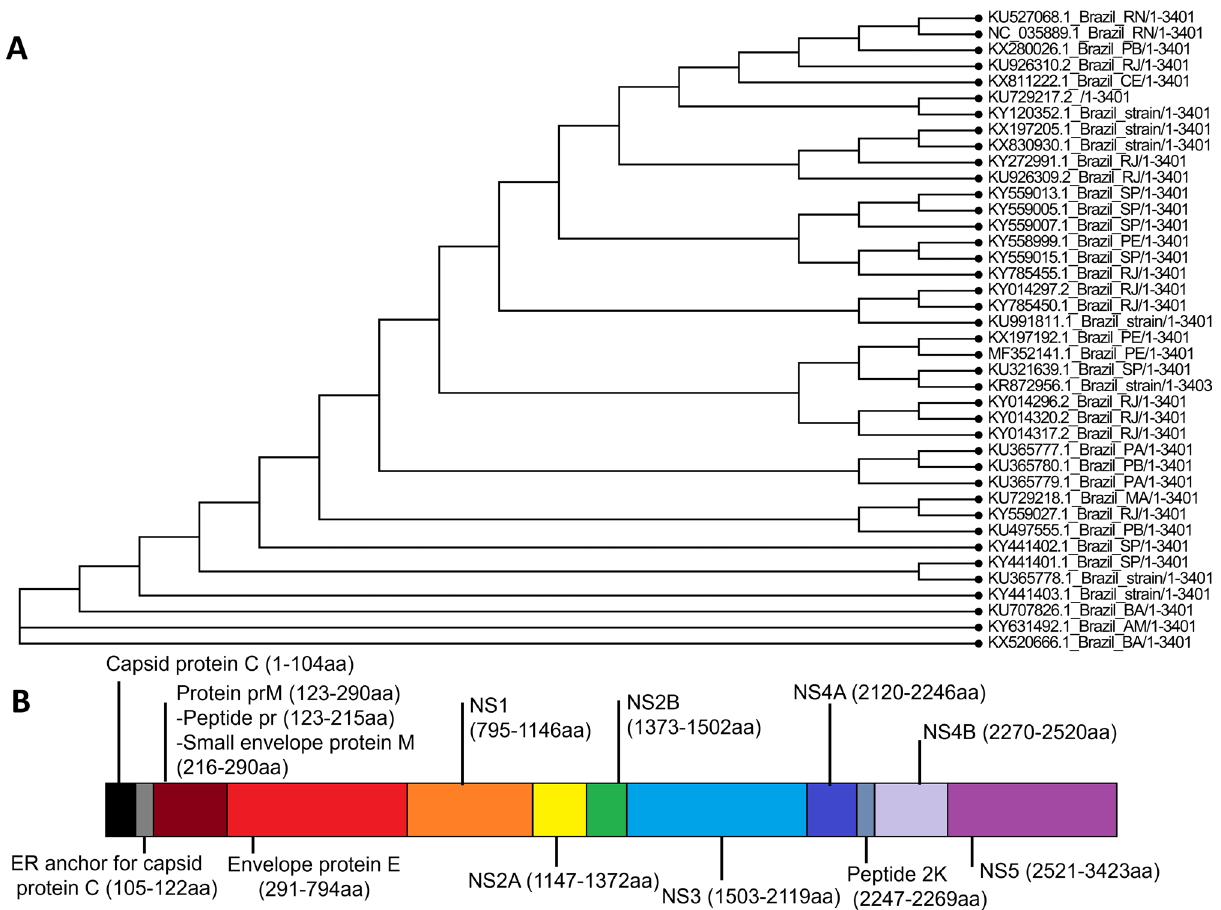
Figure 1. Phylogenetic tree of the 40 complete ZIKV strains used for obtaining the consensus sequence ( A ). ( B ) Polyprotein of the ZIKV from the Brazilian consensus sequence. The ZIKV genome codes for seven non- structural proteins (NS1, NS2A, NS2B, NS3, NS4A, NS4B and NS5) and four structural proteins (Capsid protein C, Protein prM, ER anchor for capsid protein C and Envelope protein E). Protein prM is further digested into Peptide pr and Small envelope protein M. ER anchor for capsid protein C is removed by serine protease NS3. The consensus sequence was obtained from 40 complete Brazilian sequences deposited on